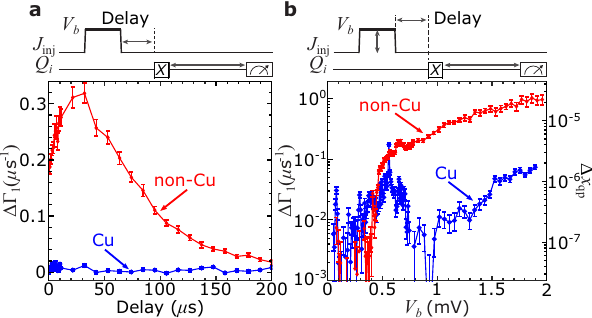
Fig. 2 | Suppression of T 1 from controlled phonon injection. a ΔΓ 1 vs. delay followinginjectionpulsefor Q C onnon-Cu(red)chipand Q B onCu(blue)chipwith V b for non-Cu and Cu chips with 30- μ s delay. Error bars com- V b =1mV. b ΔΓ 1 vs. puted from 95% con fi dence intervals from T 1 fi ts (see Supplementary Note 5).